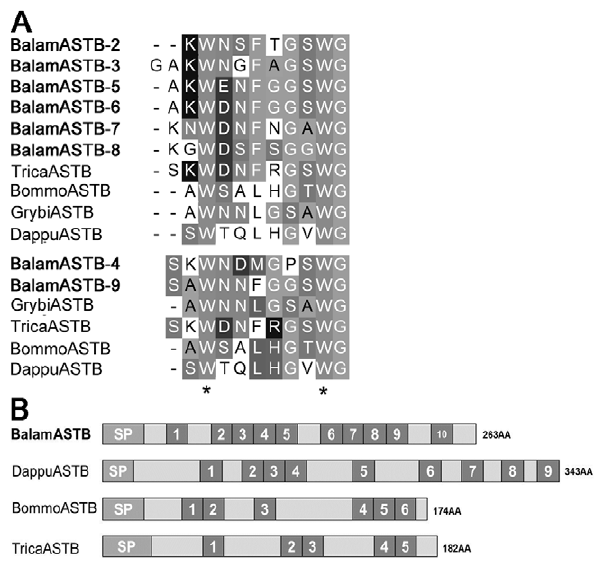
Figure 5. Comparison of barnacle B-type allatostatin with other arthropods. (A) Mature ASTB sequences alignment. (B) Precursor structure of barnacle ASTB compared with other crustaceans and insects. Insects ASTB are from: Bombyx mori P82003, Tribolium castaneum B8XQ58 and Gryllus bimaculatus Q5QRY7; branchiopod ASTB is from Daphnia pulex E9GSK4. Asterisks ‘‘*’’ represent conserved motif residues.